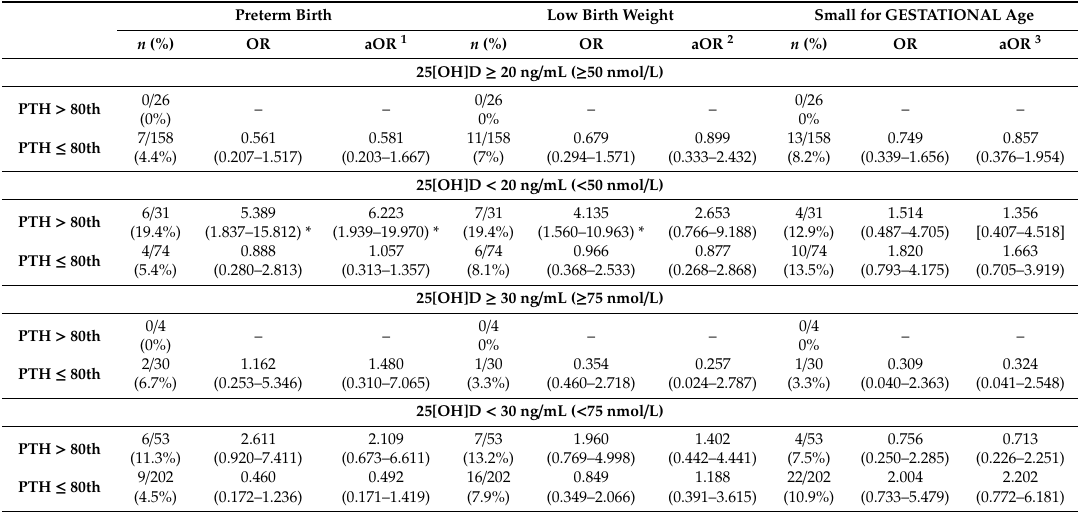
Table 5. Associations between combination of maternal serum 25-hydroxyvitamin D and PTH 80th percentile and perinatal adverse outcomes. Preterm Birth Low Birth